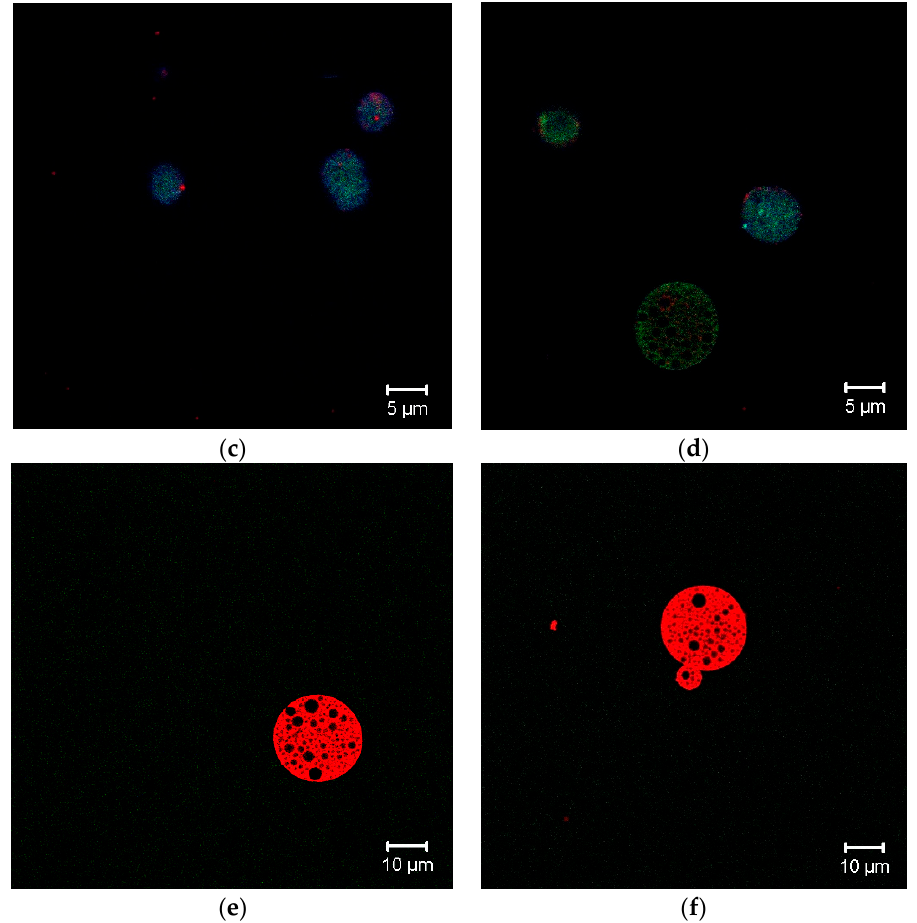
Figure 7. Confocal microscopy images during in vitro digestion: ( a,b ) at the end of the gastric phase, ( c,d ) at the beginning of the intestinal phase, and ( e,f ) at the end of the intestinal phase. Note: blue color, polysaccharides; green color, protein; red color, oil.